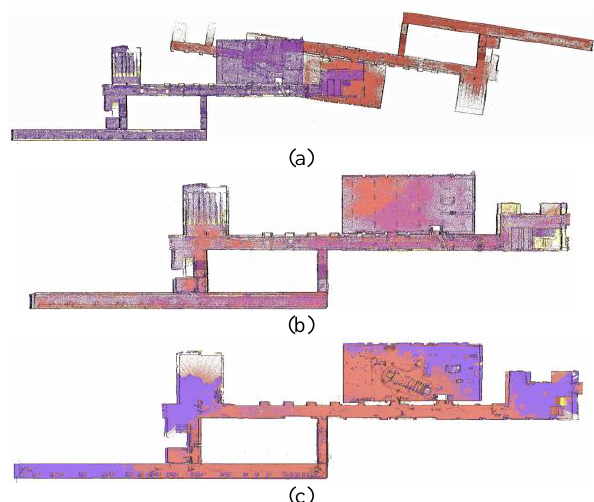
Figure 8. View of the merged point clouds: (a) without alignment; (b) manual alignment; (c) alignment with